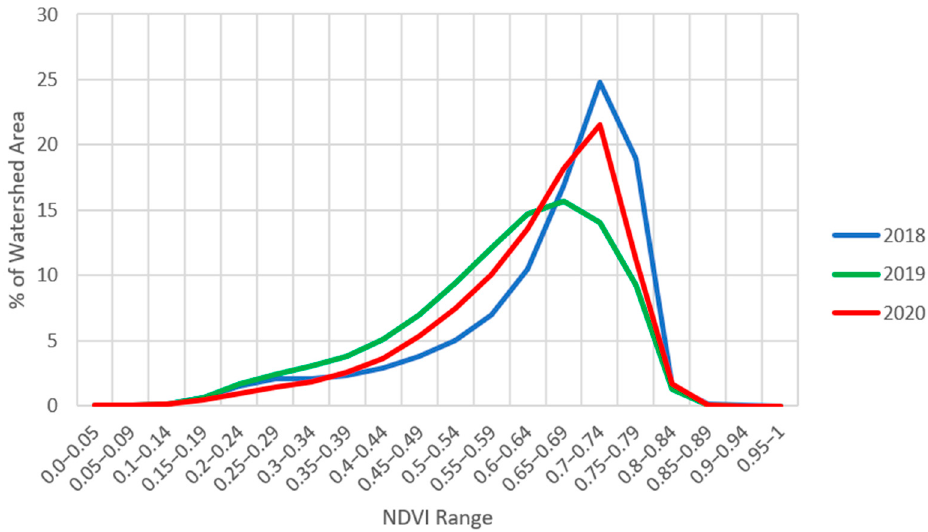
Figure 4. Growing season Sentinel-2 NDVI distribution between 2018, 2019, and 2020 within the Chipola River watershed. Average NDVI values were approximately 0.64, 0.59, and 0.62 for 2018, 2019, and 2020.